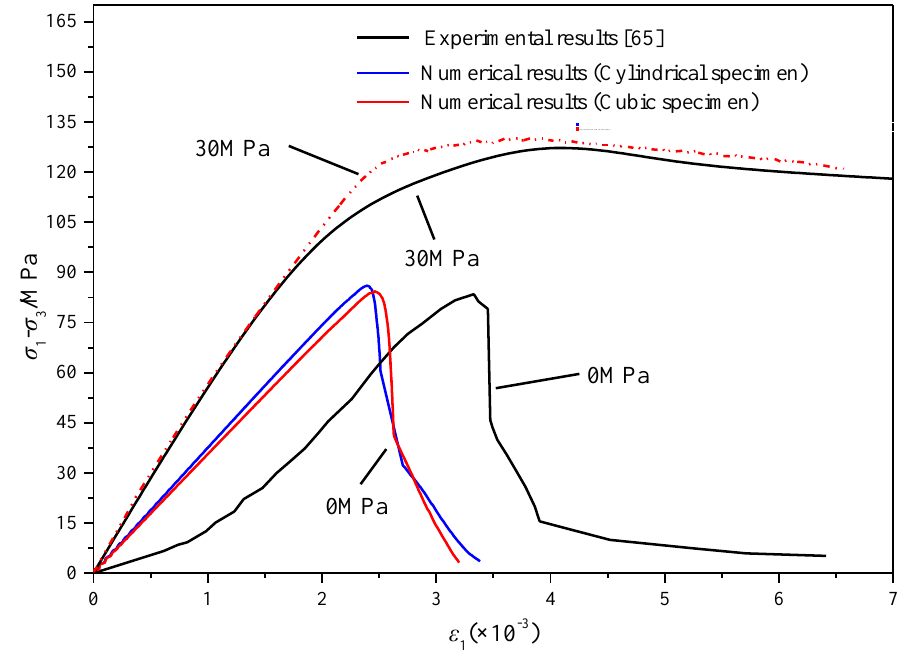
Figure 5. Comparison of axial stress–strain curves obtained from the numerical simulations and the previous experimental data [65]. Table 1. Microscopic mechanical parameters of marbles in the discrete element simulations.